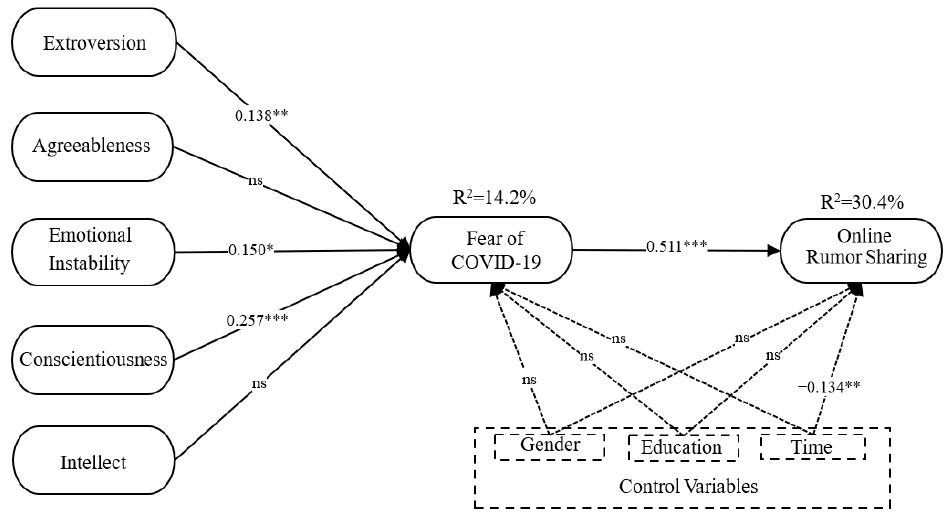
Figure 2. The research model. (Note: 1. *: p < 0.1, **: p < 0.01, ***: p < 0.001, ns: non-significant. 2. Time = Time spent on social media).